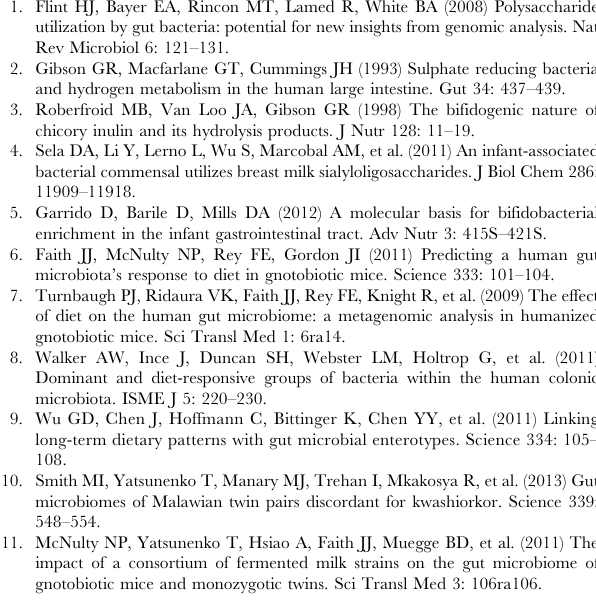
Table S9 Number of proteins detected within each cecal sample for each species in our custom SEQUEST database. Table S10 Raw and normalized MS/MS spectral counts for detectable proteins in E 1 cecal samples. Table S11 Growth of B. cellulosilyticus WH2 and B. caccae on a panel of structurally diverse carbohydrates. Table S12 Preparation of minimal medium for in vitro gene expression profiling of B. cellulosilyticus WH2. Table S13 Carbohydrate substrates tested during in vitro gene expression profiling of B. cellulosilyticus WH2. Table S14 RNA-Seq gene expression values for B. cellulosilyticus WH2 grown in vitro on 31 simple and complex saccharides. Text S1 Supplementary